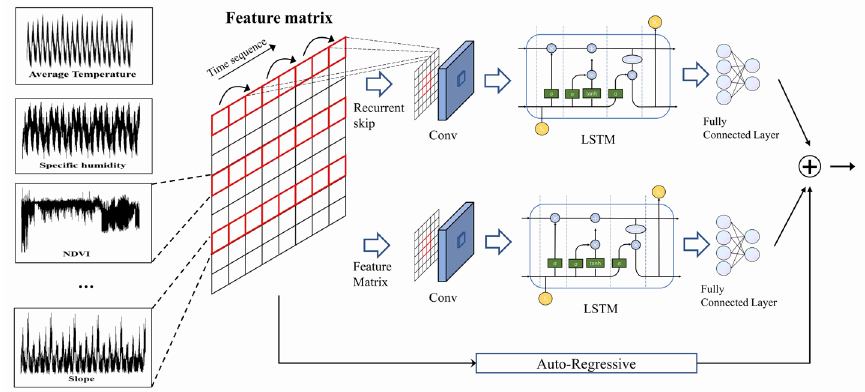
Figure 4. The structure of the LSTNet. LSTNet is a long- and short-term time-series